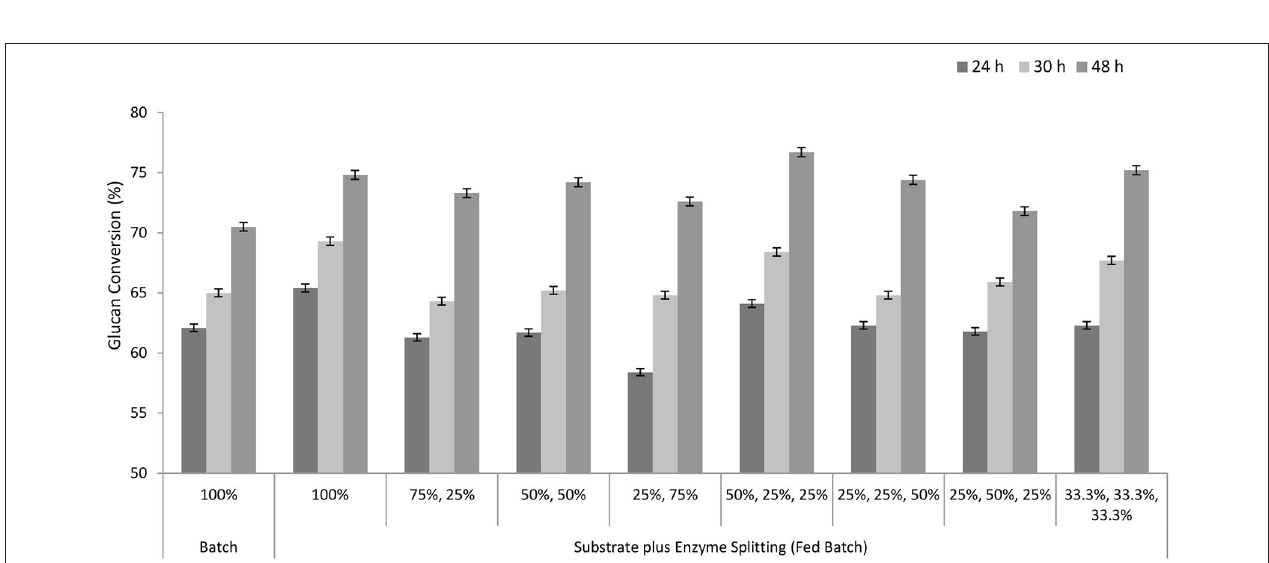
FIGURE 6 | Glucan conversion during substrate plus enzyme splitting in fed-batch experiments. Time (0, 4, and 8h) and size of the substrates (50, 25, and 25%) were constant.